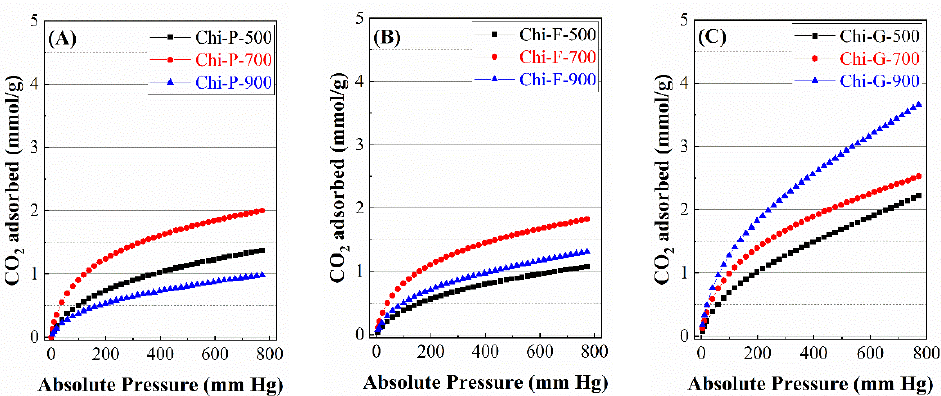
Figure 9. CO 2 adsorption isotherms at 25 ◦ C and 1 bar of the biochars obtained after the pyrolytic treatment of chitosans with different textural properties at 900 ◦ C. ( A ) biochars obtained form chitosan directly, ( B ) biochars obtained from chitosan in the form of film and ( C ) biochars obtained from chitosan in globular form.